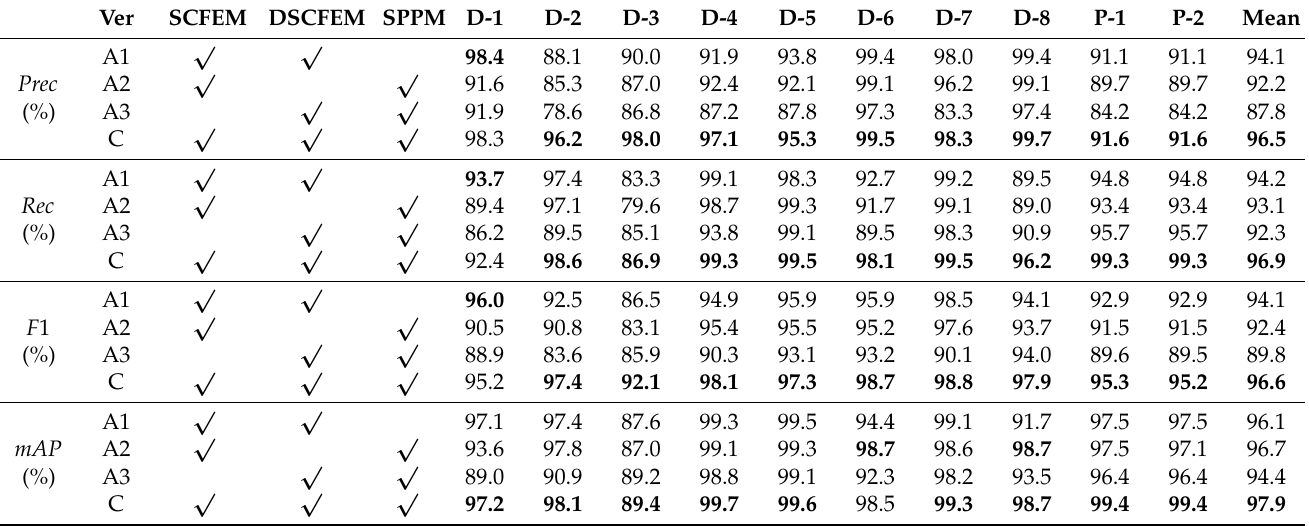
Table 3. YOLO-JD the results of the peeling test of the network on the Object Detection task. The best measures are in boldface. The “√” sign means deployment in network.